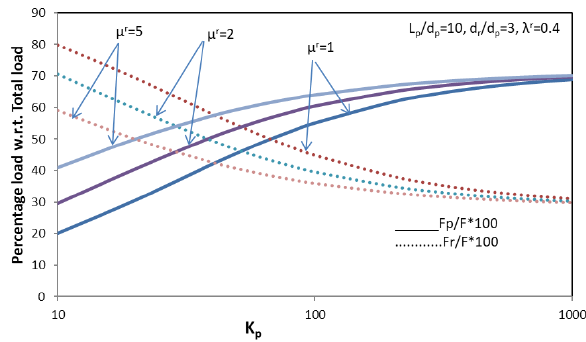
Figure 18: Variation of contact pressure (p r* =F distance from the center of raft R * =r/d factor, μ r , and vertical and radial compatibility of displacement on a partially strengthened GP–raft and solid raft (K d =3, λ r =0.4). p